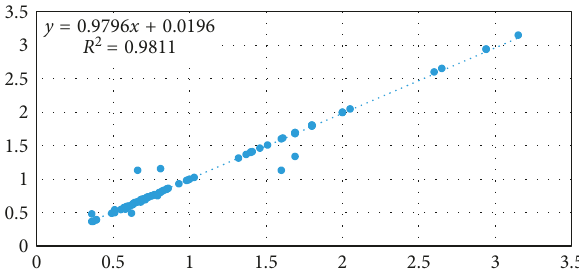
Figure 10: ANN training results for the prediction of the U-opaque in single-family